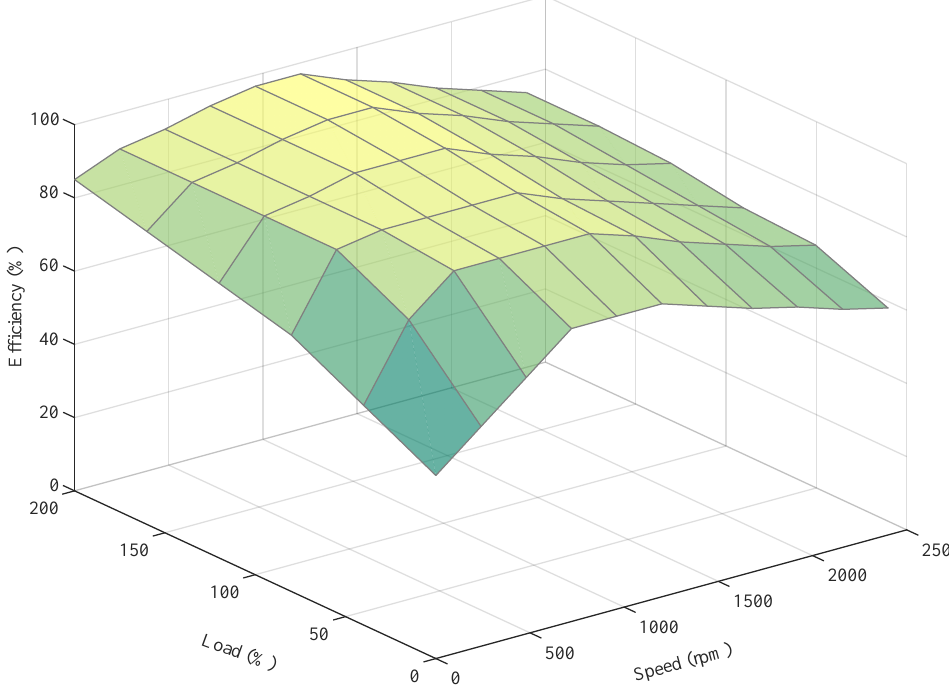
Figure 6. Efficiency map of the electric motor and inverter set-up. All three powertrain configurations are simulated with two different load scenarios, resulting in six separate simulation cases. The cargo load profiles represent the truck with its maximum mass, whereas the snow load profiles represent the corresponding version with additional driving resistance from snow ploughing, but with a smaller overall mass. The load case description is added to the vehicle profile denotation (either with ‘cargo’ or